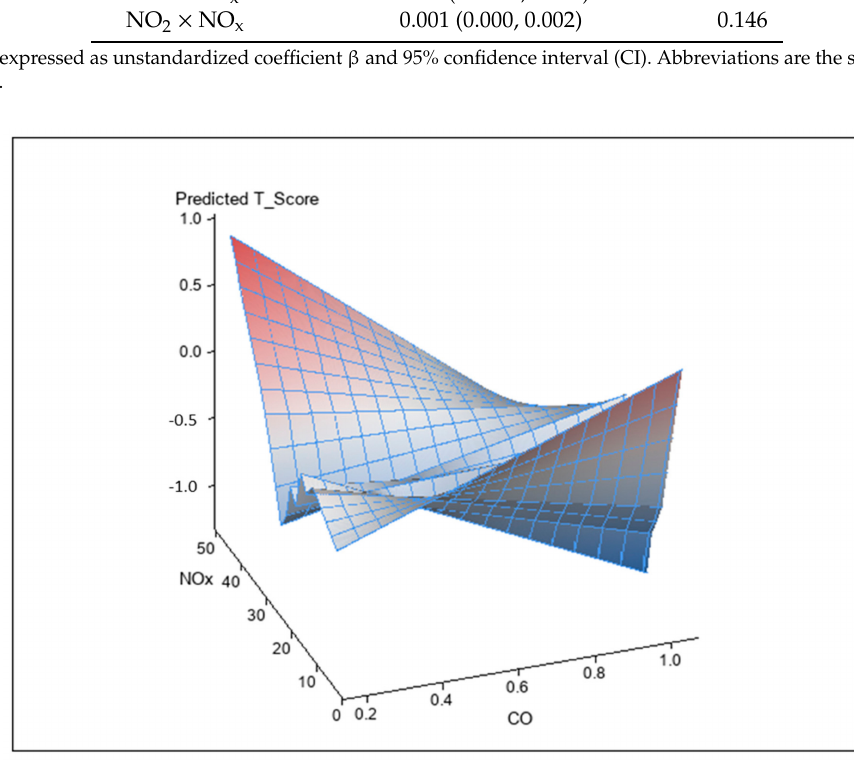
Figure 2. Synergistic e ff ect of CO and NO x on BMD T-score. The interaction between CO and NO x on BMD T-score was statistically significant ( p =